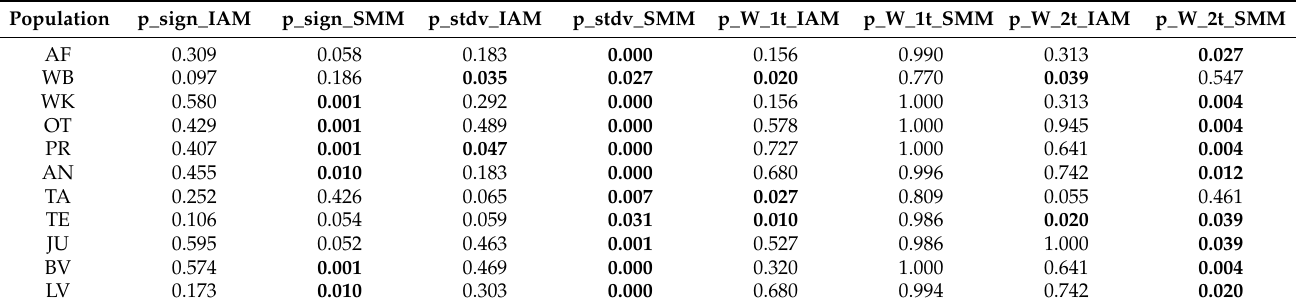
Table 3. Summary statistics and p -values for bottleneck tests conducted for wild O. niloticus popula- tions 1 . Tests with significant p -values ( α = 0.05) are indicated in bold. Sign = sign test, stdv = standard differences test, W_1t = Wilcoxon one-tailed test, W_2t = Wilcoxon two-tailed test. IAM = infinite allele model, SMM = stepwise mutation